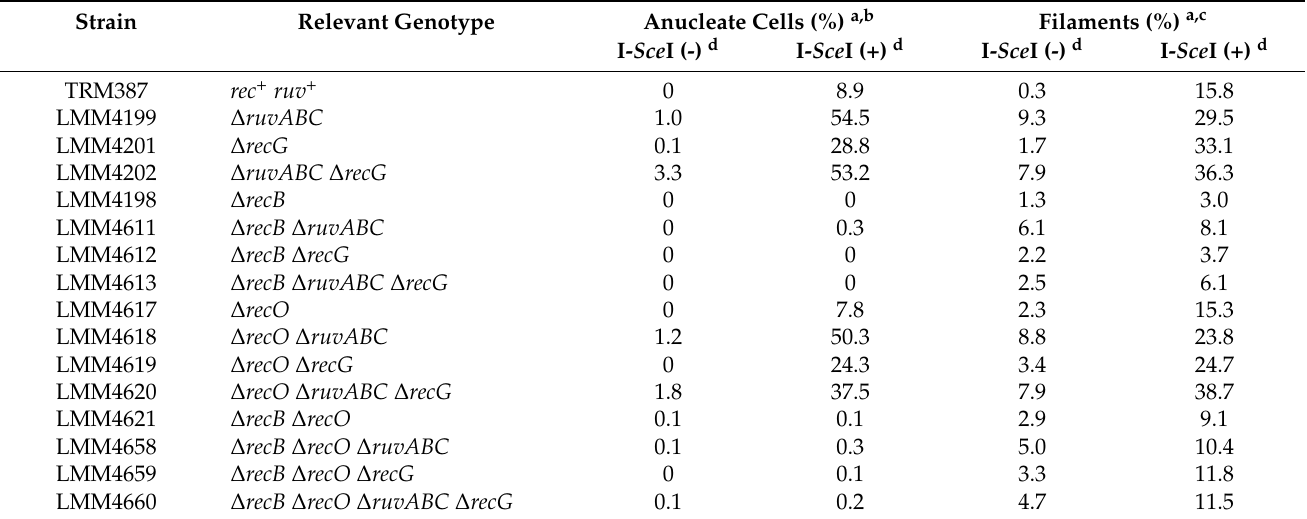
Table 2. Production of anucleate cells and filaments in exponential cultures of different E. coli strains before and after I- Sce I endonuclease expression. Statistical analysis is provided in Table